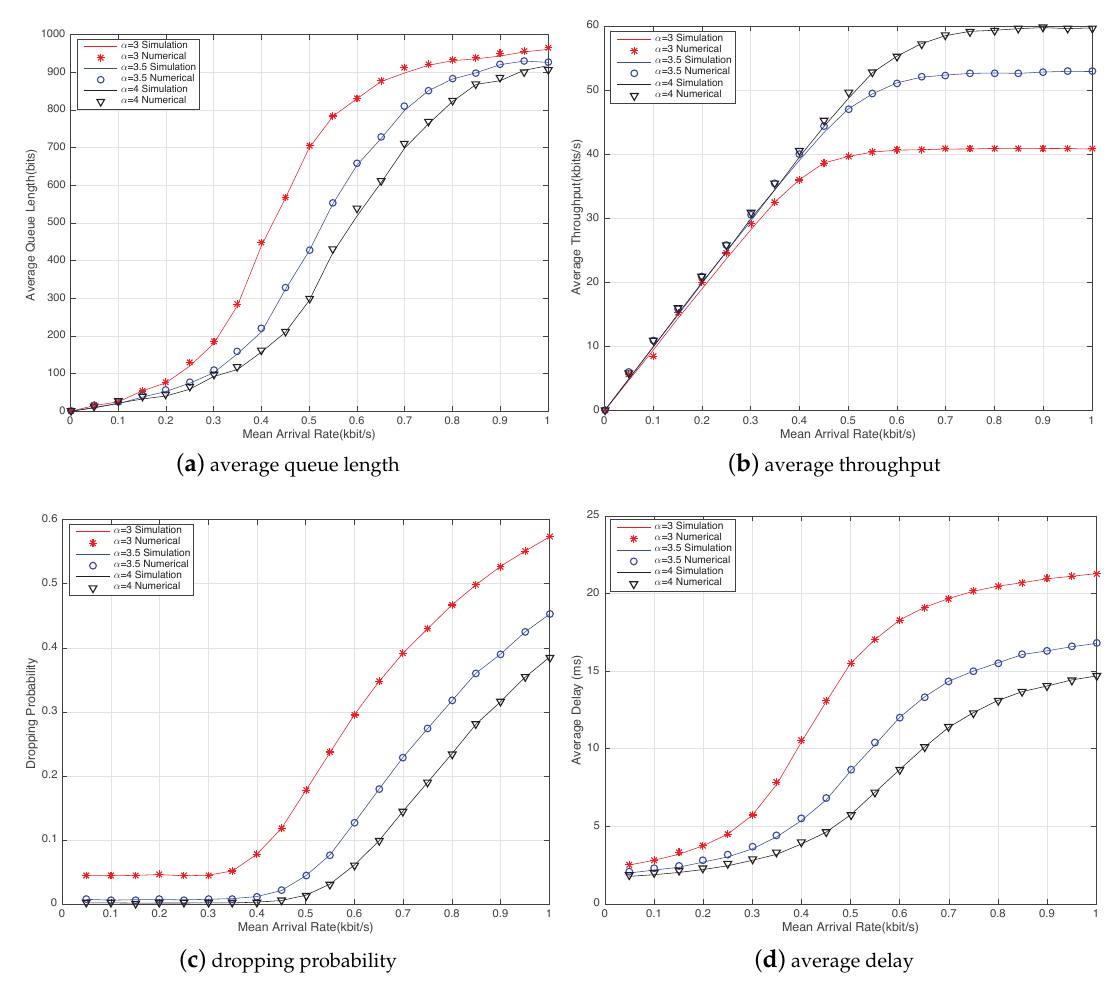
Figure 3. The D2D performance parameters versus packet arrival rate under different path loss factors α